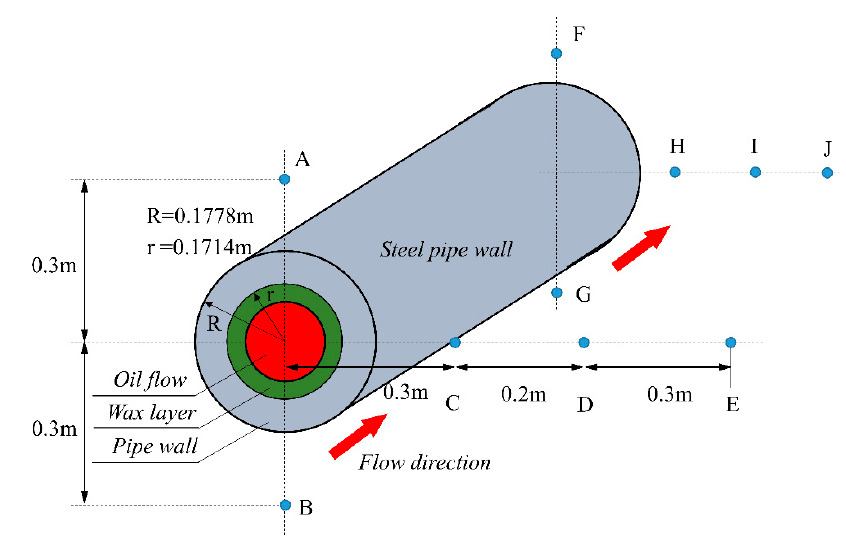
Figure 5. The location of temperature detecting sensors.